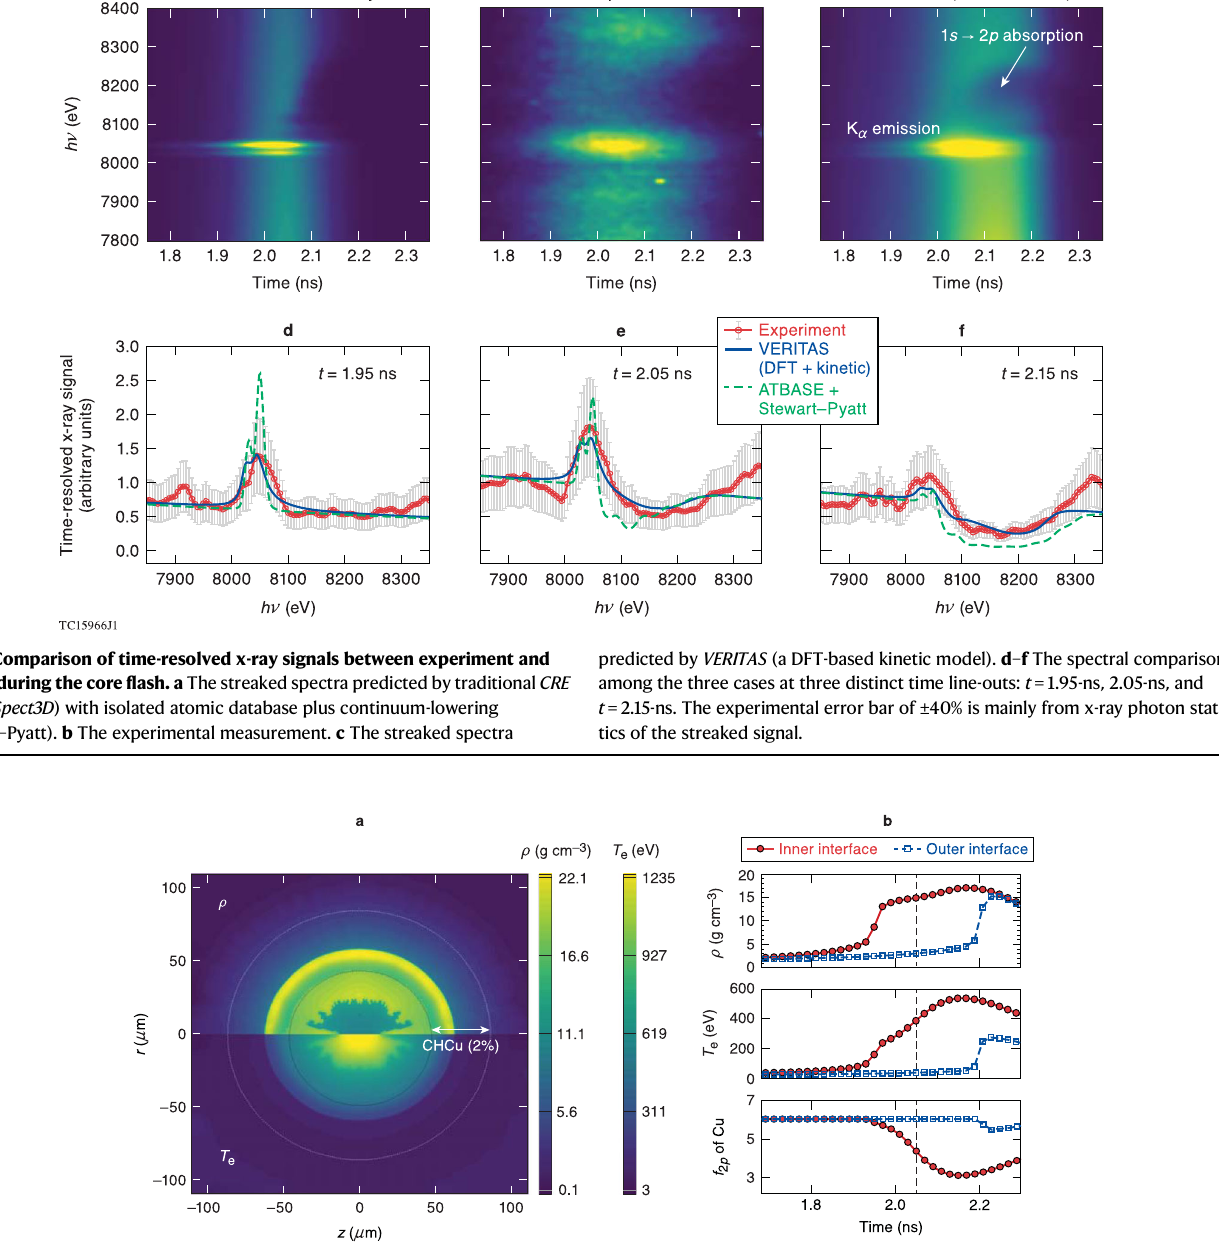
layerwhoseregionismarkedbytheblackarrow. b Thetimeevolutionofplasma ρ / T conditions as well as the population of Cu ’ s 2p state in the Cu-doping region (inferred by VERITAS ) during the core fl ash, in which red symbols represent the situation at the inner interface and blue symbols are for the outer interface. The stagnation time (t=2.05ns) is marked by the vertical dashed line.